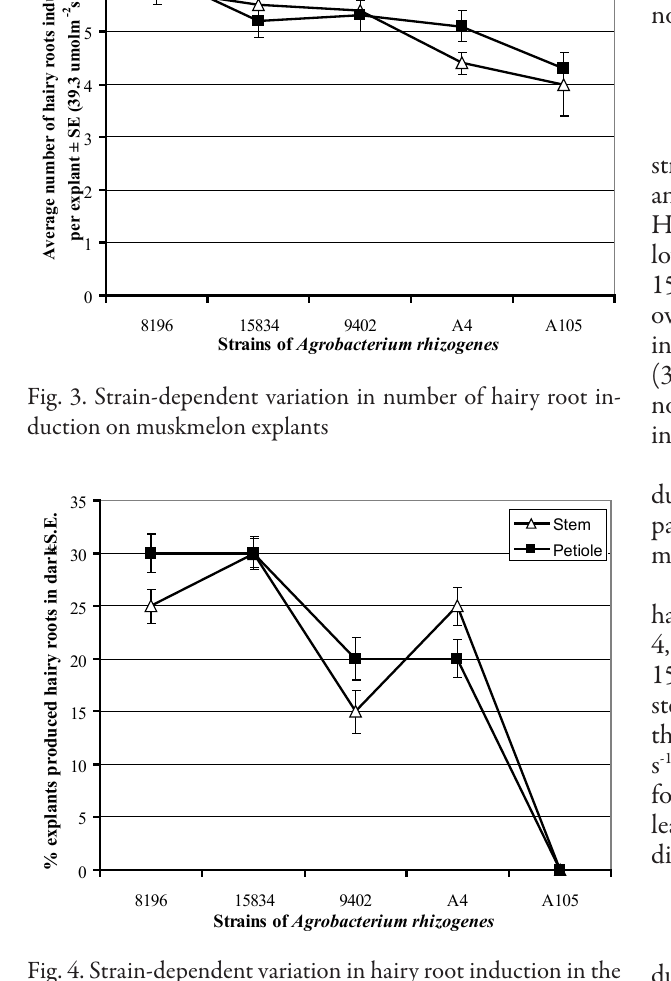
Fig. 4. Strain-dependent variation in hairy root induction in the dark on muskmelon